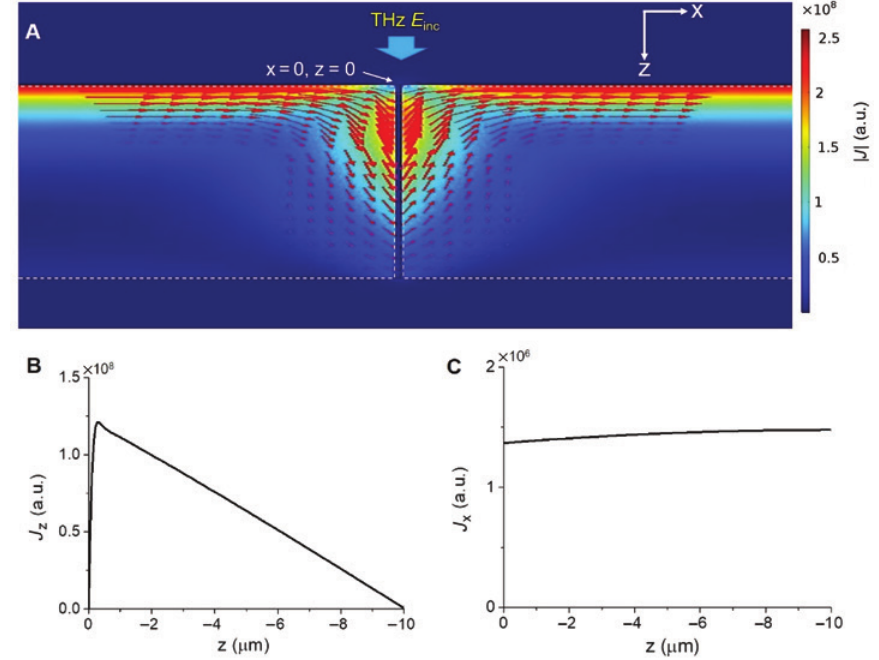
Figure 6: Field enhancement with thick slit. (A) Numerically calculated map, using the COMSOL software, of the current density with thick slit in freestanding gold, showing “dumping the charge”. 0.5 THz light is incident from the top side onto the gap of w = 10 nm and h = 10 μ m. Metal surfaces are denoted by white dashed lines. Cross-cut profiles of (B) J and (C) J along the left metal edge in the gap [from (0, 0) to (0, − h )] are present. z x